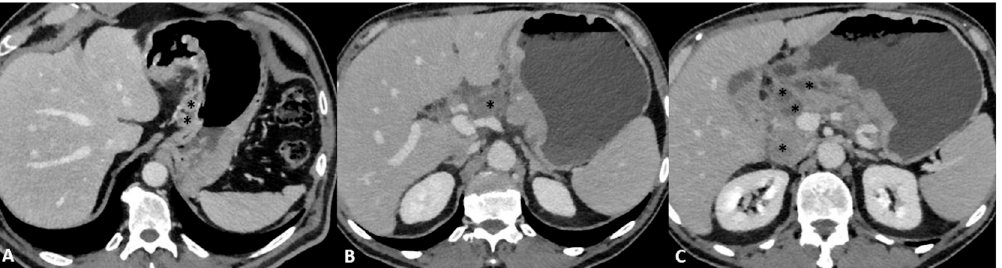
Figure 8. Axial 2D images in the portal venous phase show different pathological node locations (black asterisks): ( A ) pathological lymph nodes in the lesser curvature of the stomach; ( B ) pathological lymph nodes of the lesser curvature and the celiac artery; ( C ) pathological lymph nodes of the pancreatic head and para-aortic region. The lymph nodes in the images present an inhomogeneous contrast enhancement with central hypodensity due to the presence of necrotic components inside.